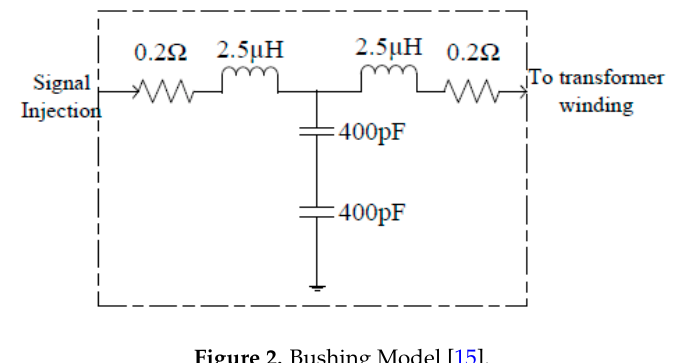
Figure 2. Bushing Model [15].